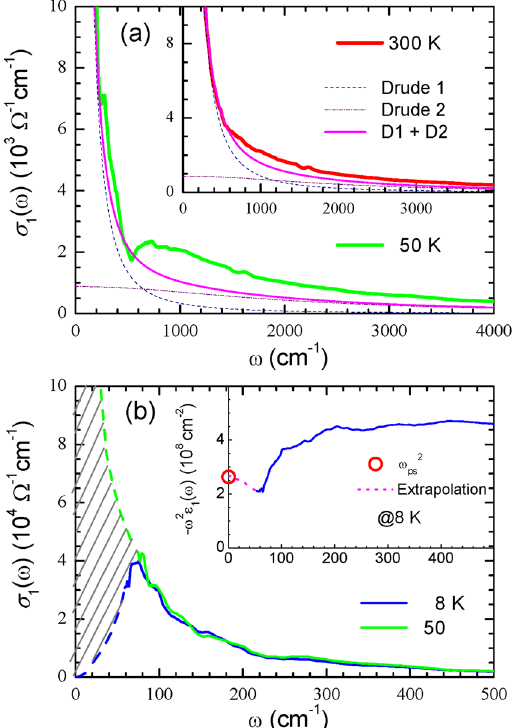
Figure 2. ( a ) The optical conductivity spectra at 50 K, with a theoretical fit using two Drude modes. In the inset we show the same spectra at 300 K. ( b ) The real part of the optical conductivity spectra in the superconducting state (8 K), and normal state (50 K). In the inset, we display the physical quantity  ω ω − ( ) 2 the dielectric function as a function of frequency. The open red symbol is the superfluid plasma frequency 2 , obtained from the FGT sum rule 22, 23 (see main squared, ω ps